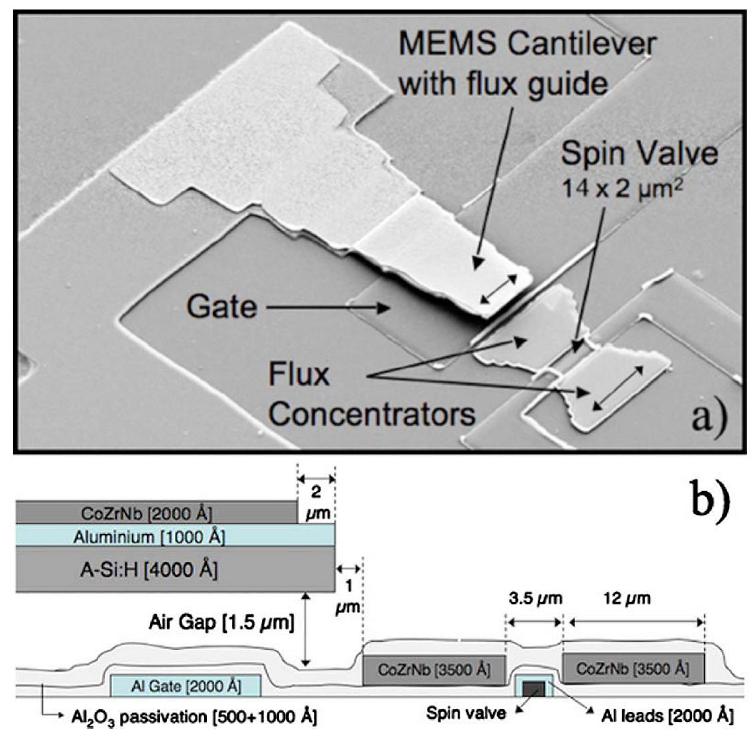
Figure 9. ( a ) SEM micrograph of the fabricated sensor with all its components: the MEMS cantilever with a 200 nm thick magnetic flux guide on top, the SV sensor (oscillating frequency: 400 kHz); ( b ) Cross sectional view of the device with all relevant features. (Reprinted with permission from